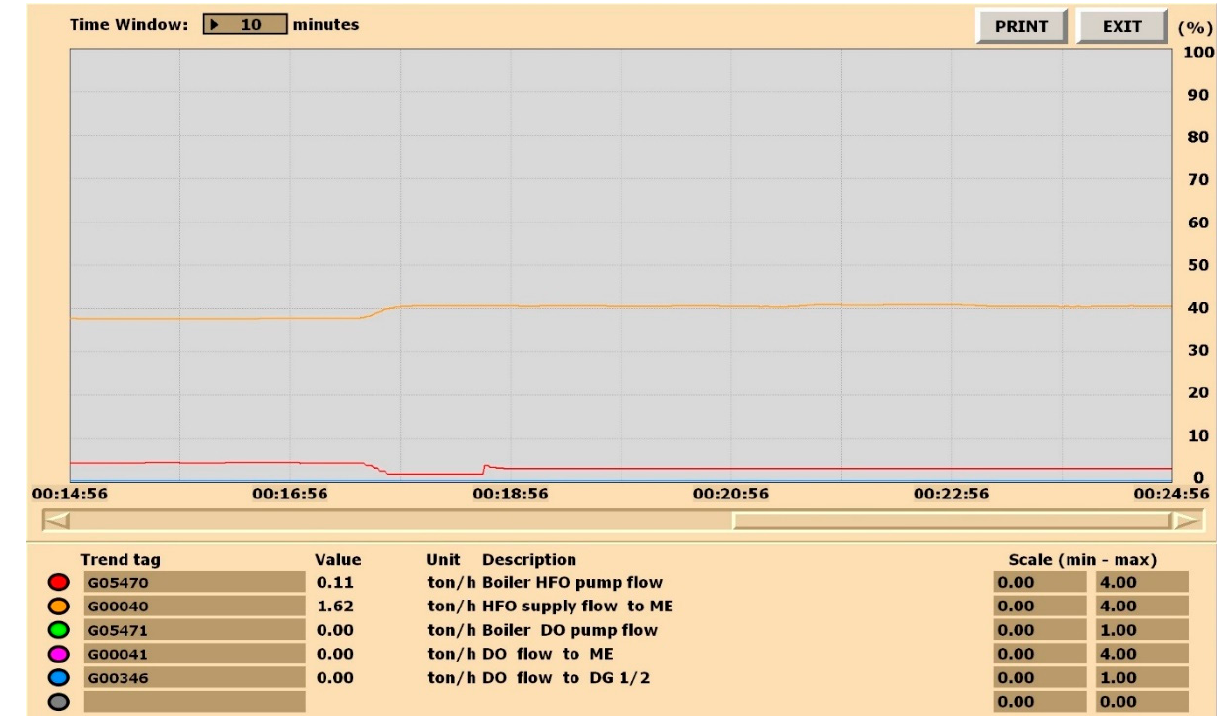
Figure 4. Fuel flows for mode 1.4.